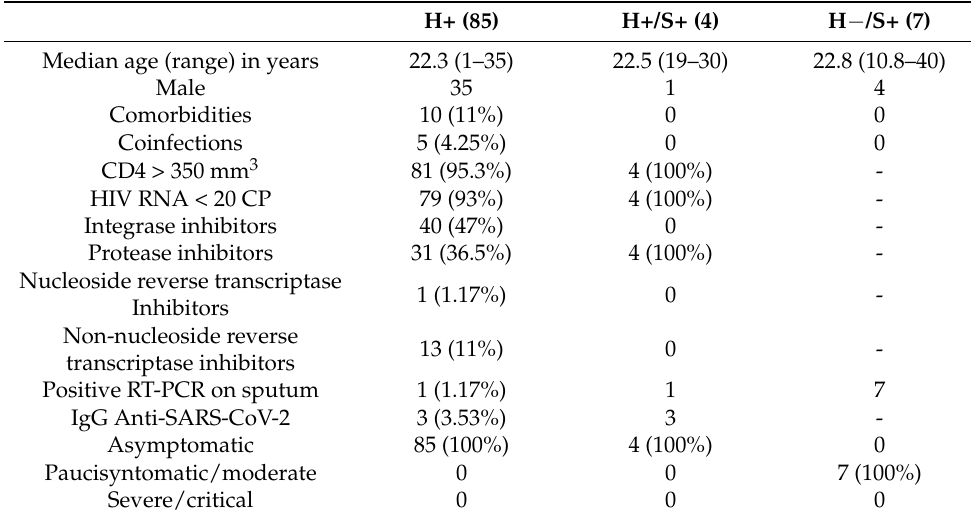
Table 1. Demographic and clinical characteristics of enrolled